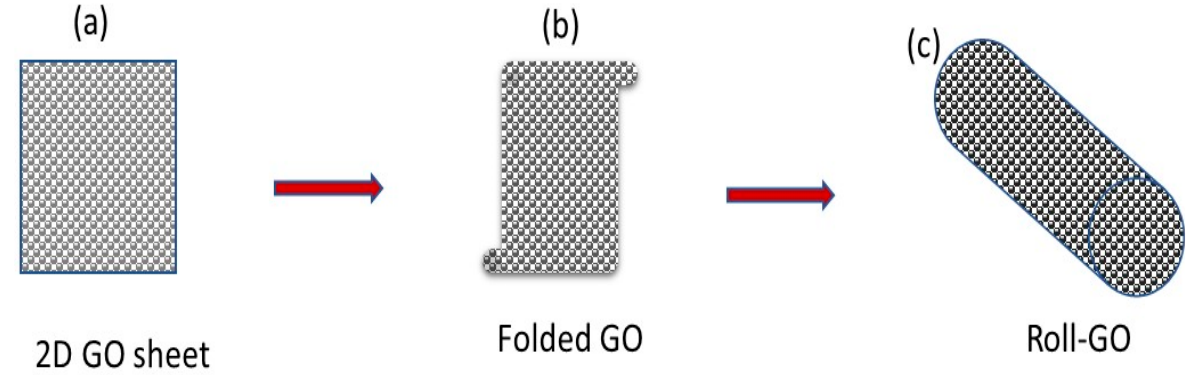
Figure 8. The schematic diagram for conversion of 2D GO into roll-GO materials; ( a ) is flat sheet, ( b ) side rolling, and ( c ) complete rolling process.